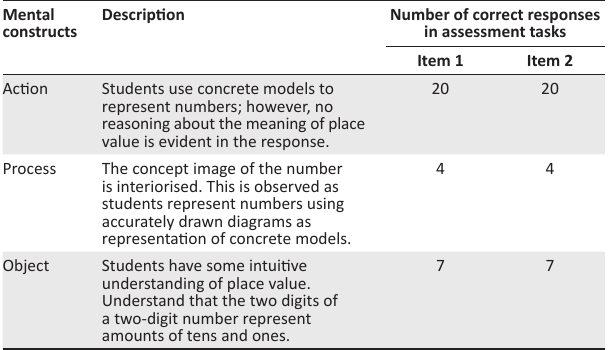
TABLE 2: Level of conceptualisation of the students’ use of manipulatives to represent whole numbers. Mental constructs